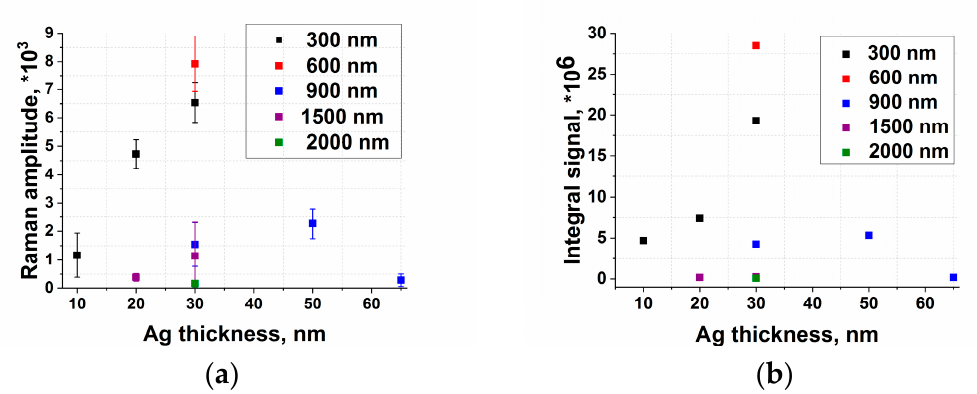
Figure 6. The study of Raman signals for samples of sandwich structures. The data are given for the amplitudes of the vibration band at 1338 cm − 1 . ( a ) Dependence of the signal amplitude on the thickness of the silver layer; ( b ) dependence of the integral signal as a result of summing the amplitudes of the vibration band at 1338 cm − 1 over the entire mapping area on the thickness of the silver layer over an area of 150 × 150 μ m 2 .